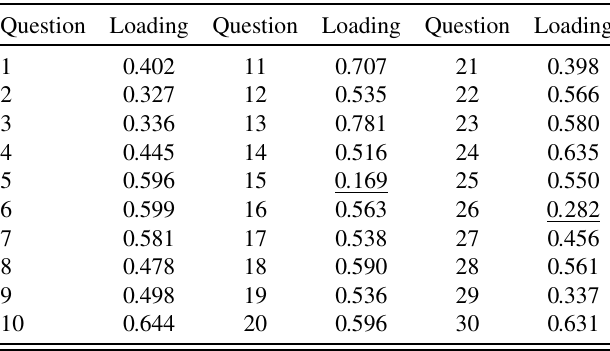
TABLE I. Pattern matrix and unique variances for a one-factor model. Note the low loadings of questions 15 and 26